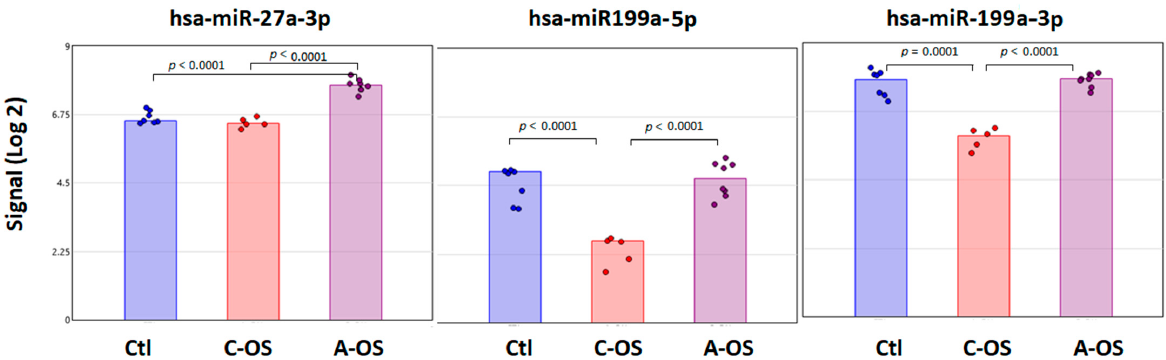
Figure 2. Individual changes in expression of exosomal miRNAs predicted to target the Nrf2 .